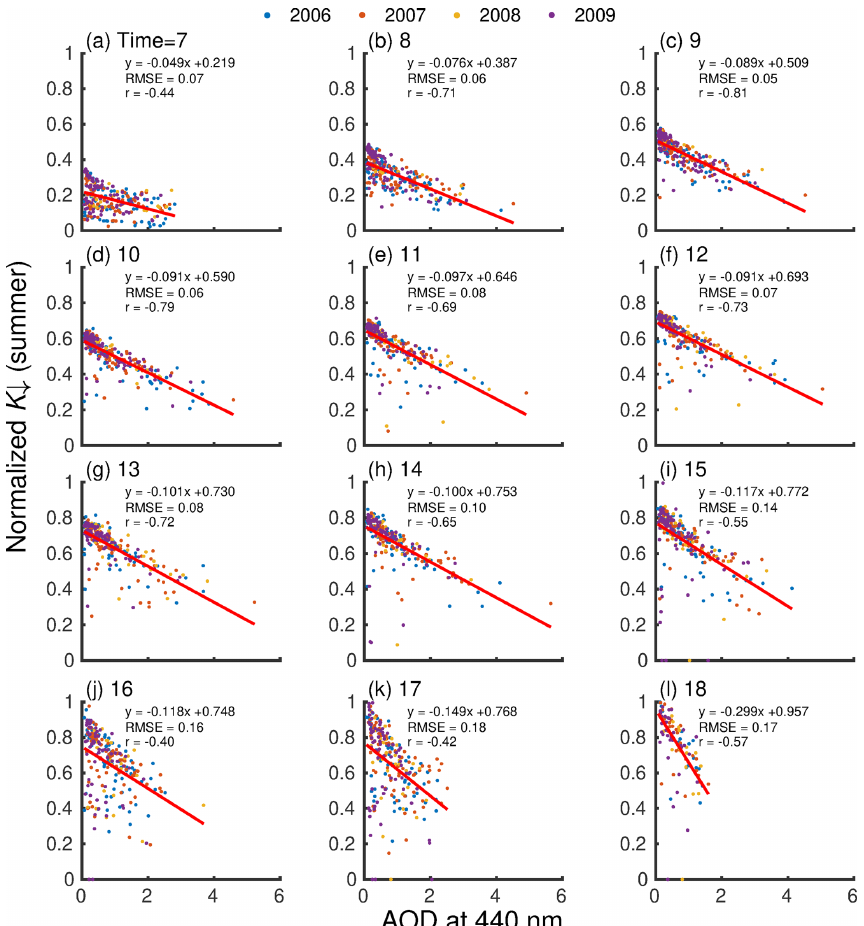
Figure 1. Observed hourly incoming solar radiation ( K ↓ ) normalized with clear-sky radiation ( I SC × cos θ z ) against aerosol optical depth (AOD) observations (Holben et al., 1998) for different hours of the day (a–l) for thermal summer months (April–September) at the 325m IAP meteorological tower (47m level; Liu et al., 2012). Winter months in Fig. A1. Linear regression (red line) is fit after LOWESS smoothing is applied for the scatter. See “Statistical methods” for more